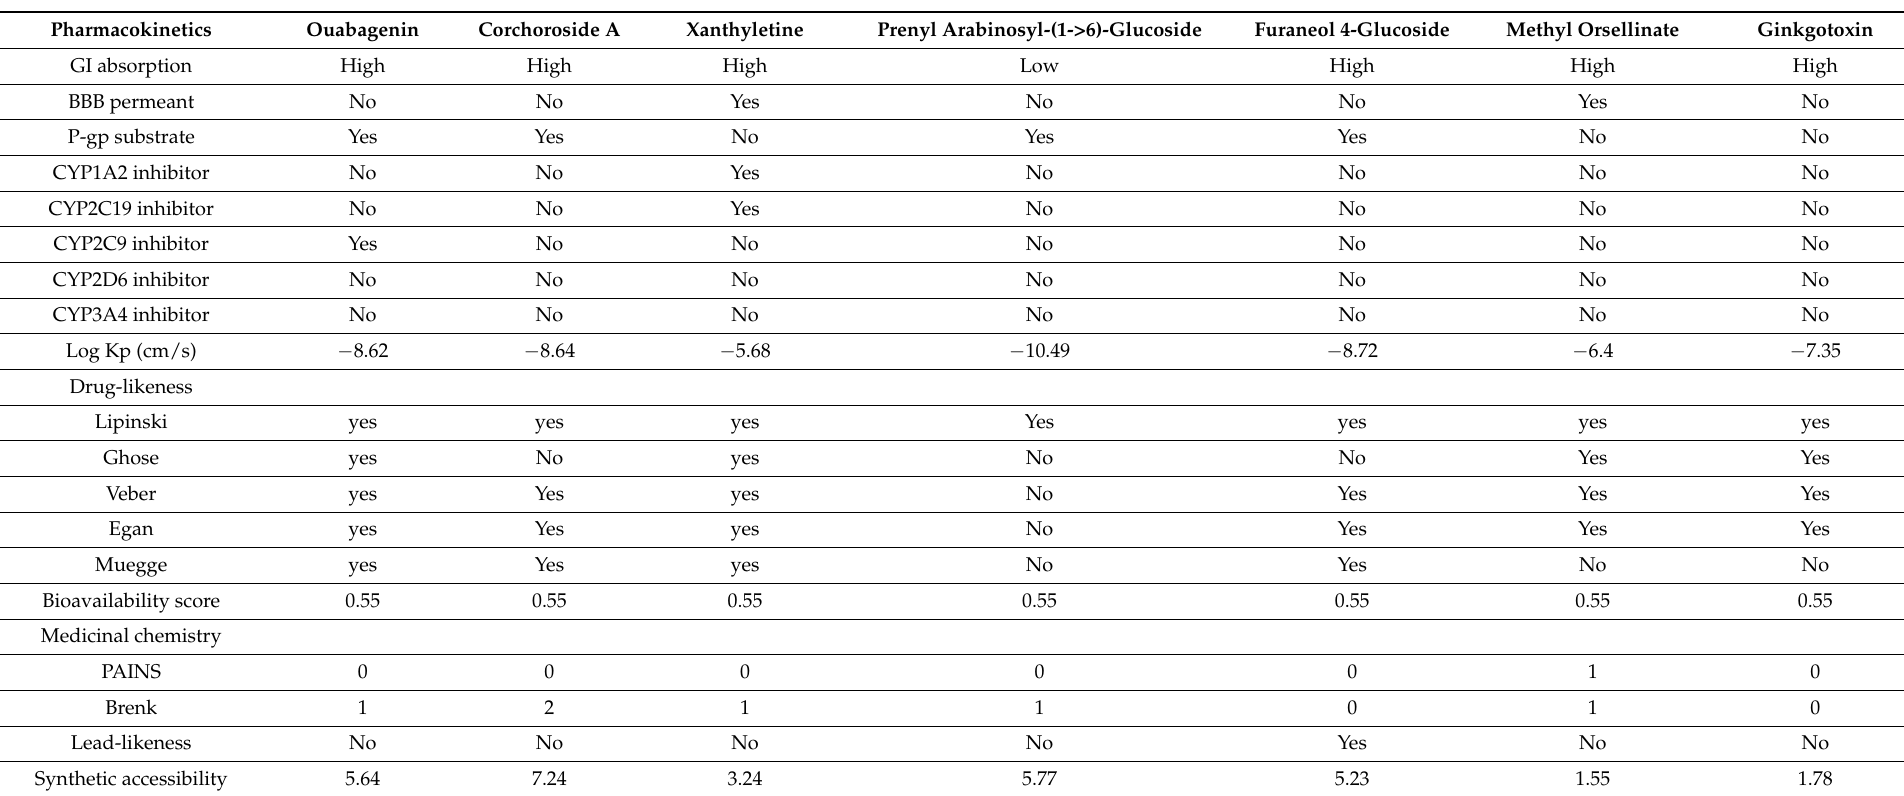
Table 5. Pharmacokinetics, drug-likeness and medicinal chemistry of latex from P. tomentosa L.’s screened secondary metabolites according to SwissADME software.